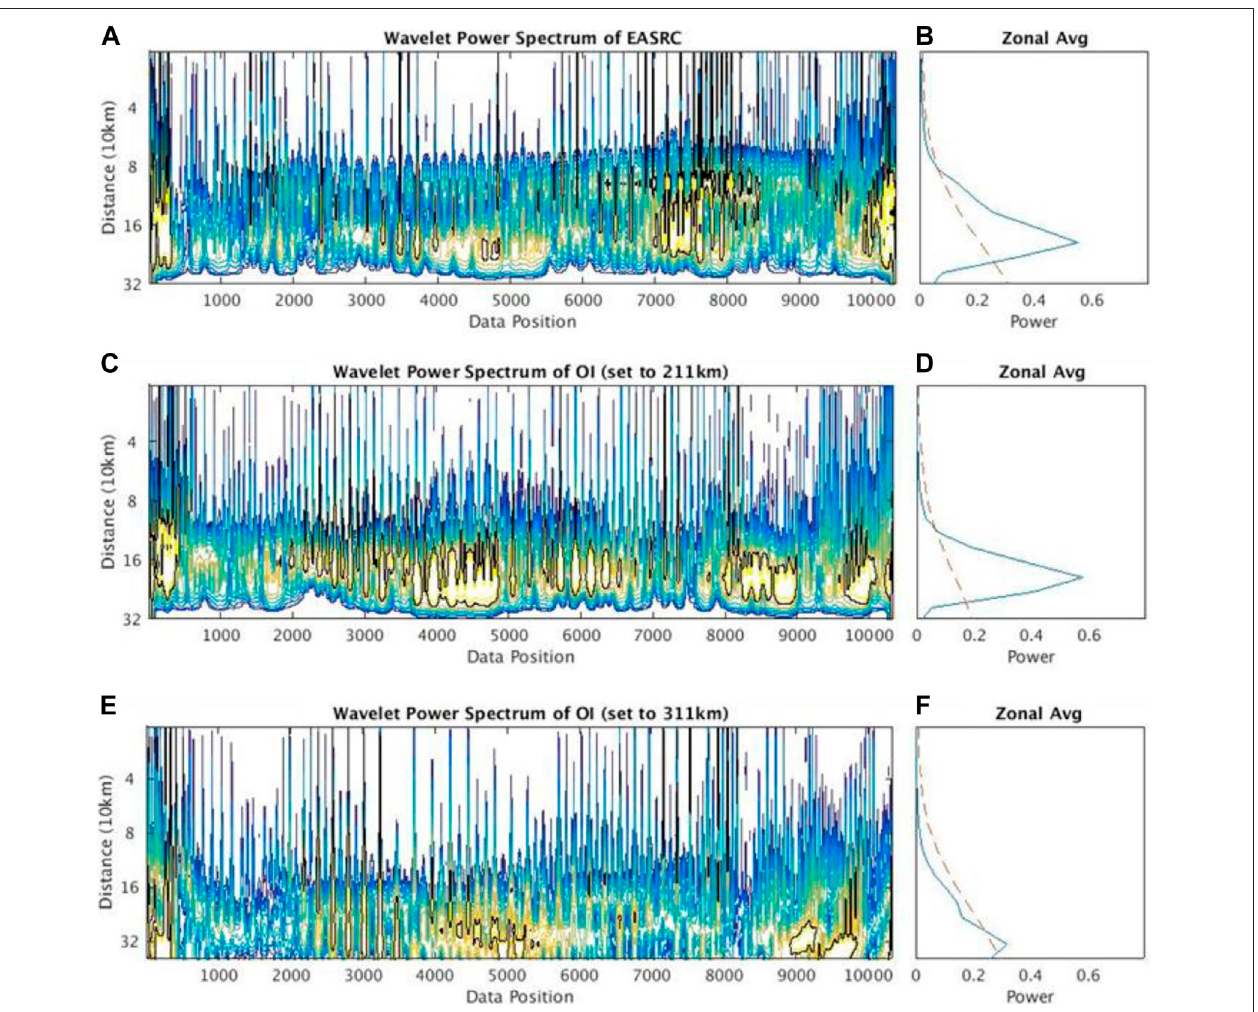
FIGURE 8 | (A) Wavelet spectrum for sea surface temperature anomaly using Morlet wavelet with 95% signi fi cant con fi dence level (black line) in February of the EASRC and (B) spatial-averagedwaveletpowerspectrum with95%signi fi cantcon fi dencelevel(dotted line).Thesameinformationexcept forOIresultsaresetto (C,D) 211 km and (E, F) 311